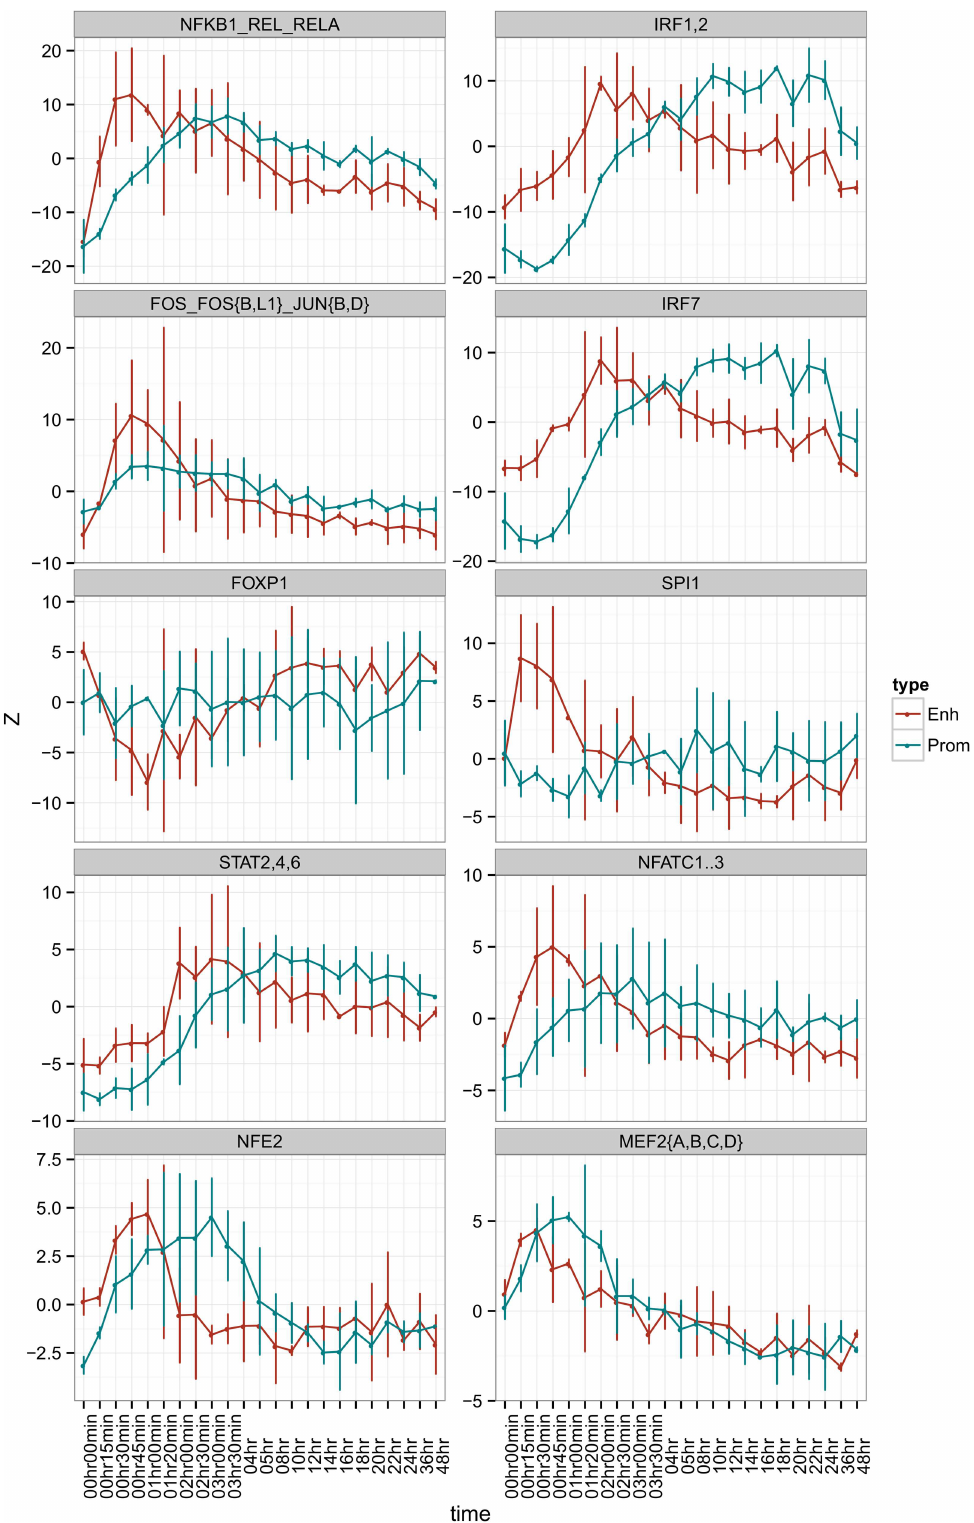
Fig 6. Motif activity response analysis (MARA) of the response to LPS MARA analysisof promoters and enhancerswas carried out as describedin Materials and Methods. MARA averages the expressionof